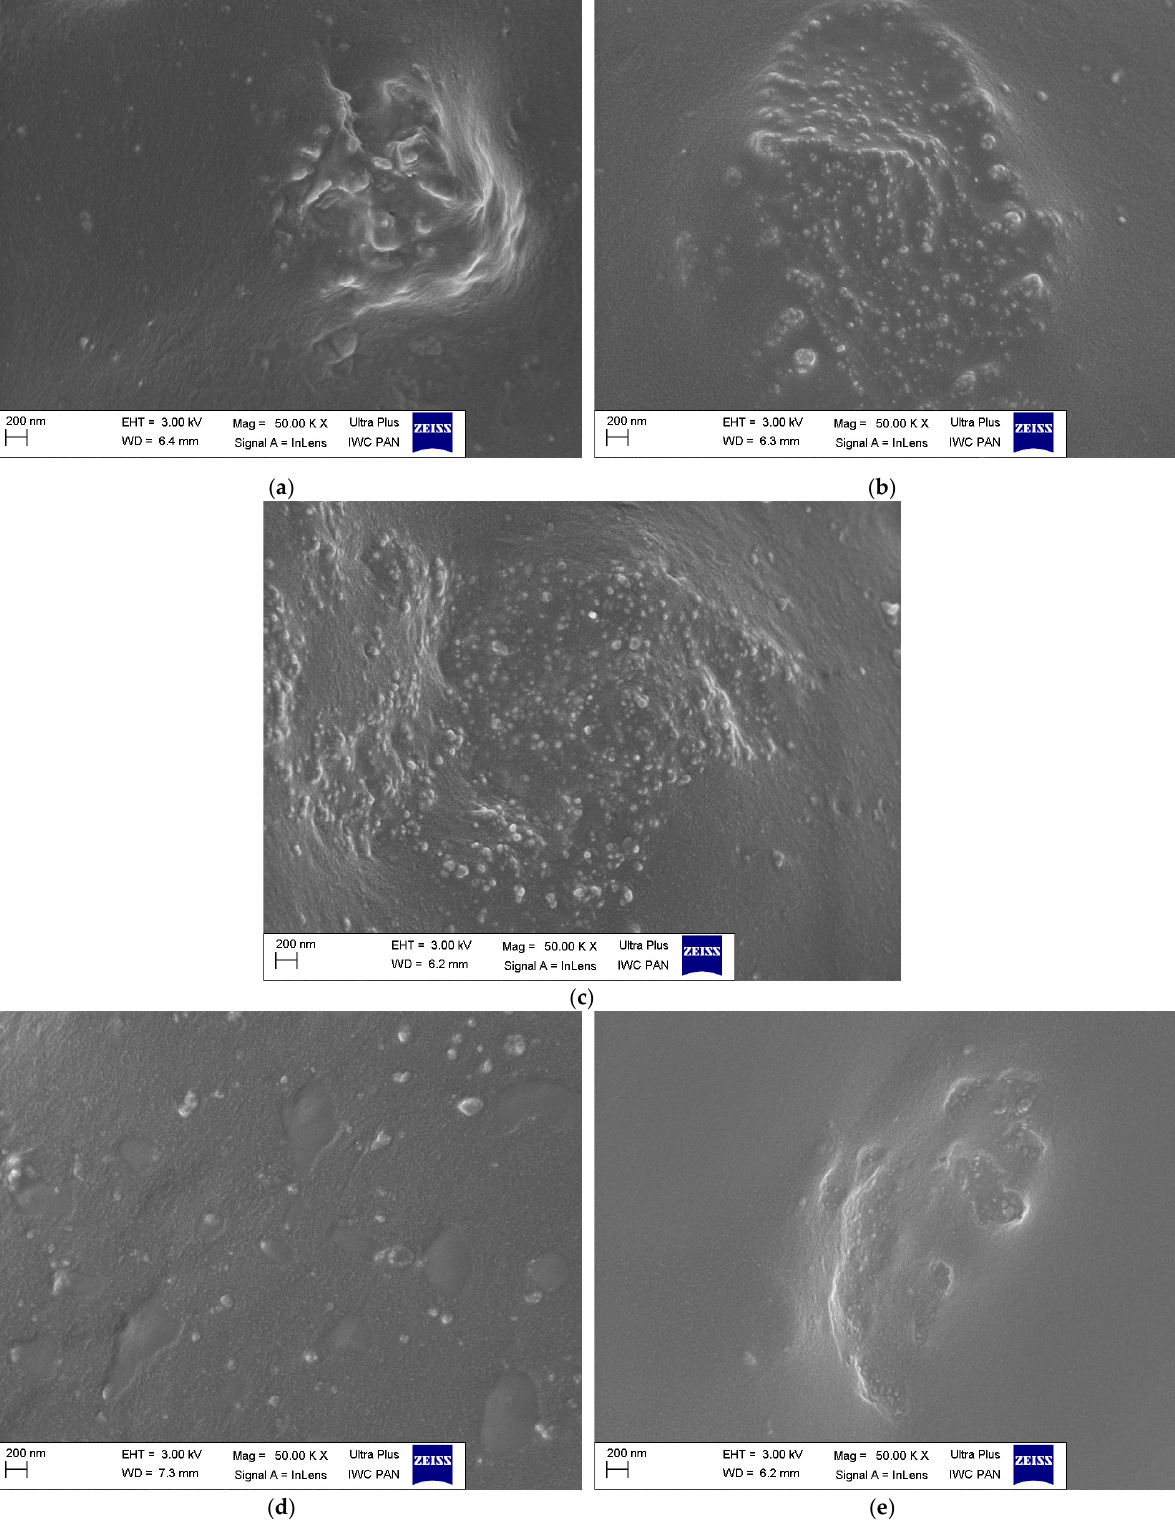
Figure 8. SEM images of NR vulcanizates filled with 40 phr of ground eggshells containing additives: ( a ) APTES; ( b ) TESPTS; ( c ) CTAB; ( d ) BmiCl; ( e )